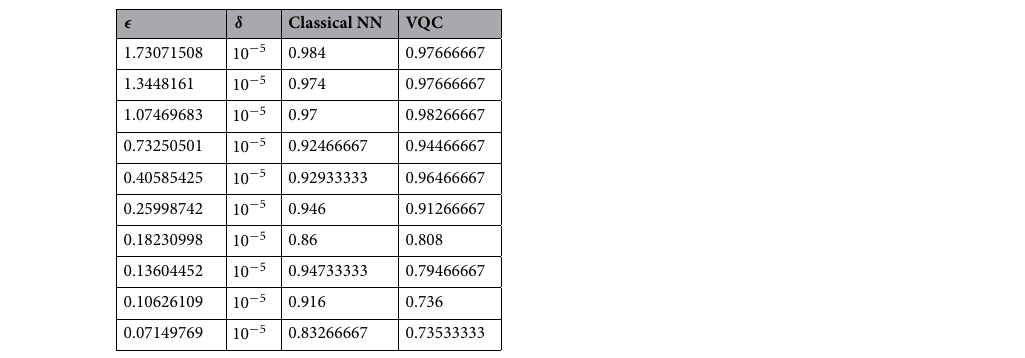
Table 3. Results from binary MNIST classification of ’0’ and ’1’ digits. Accuracies of differentially private neural networks and variational quantum classifiers after 30 epochs. The private quantum classifier is more accurate and successful for ε ’s between 0.41 and